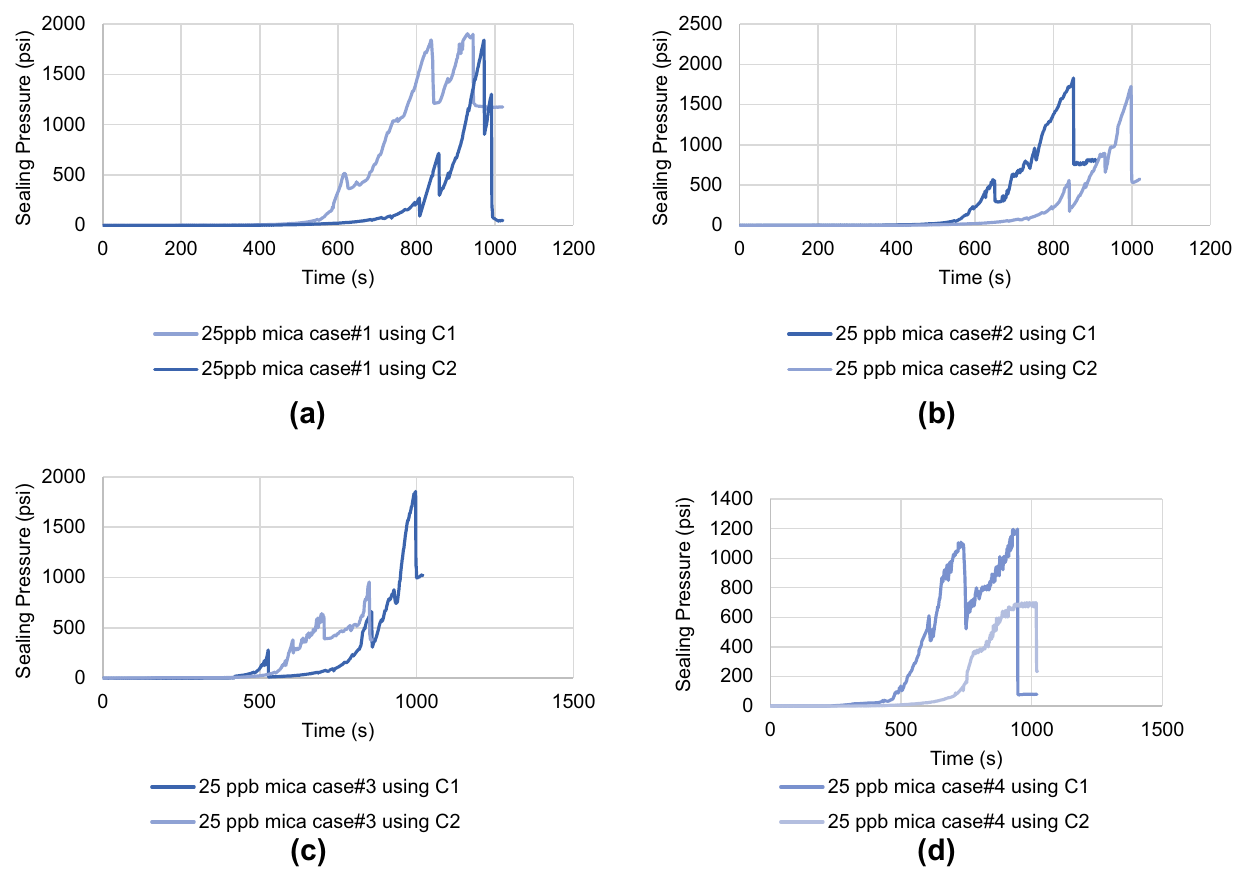
Fig. 10 HPA Pressure versus Time plot for 25 ppb Mica showing maximum sealing pressure at different fracture widths, a case#1, b case#2, c case#3, d